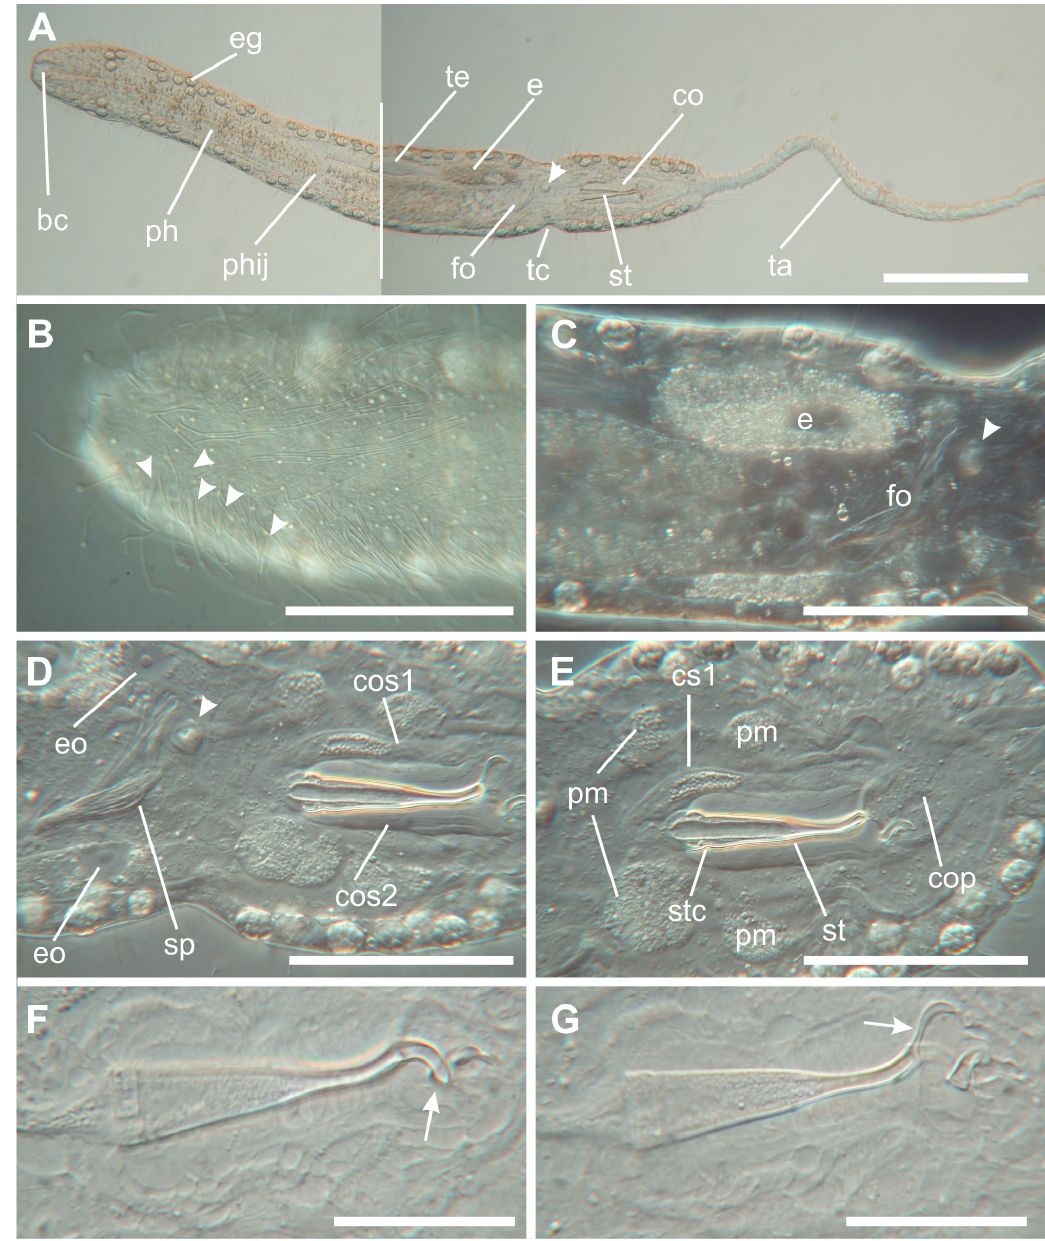
Figure 2. Photomicrographs of Urodasys bi fi dostylis sp. nov. holotype (Nomarski optics). ( A ) Habitus , showing the internal anatomy seen from a dorsal view; the arrowhead indicates the external pore of the frontal organ. ( B ) Details of the anterior end, ventral view, showing the anterior adhesive tubes (arrowheads). ( C ) Details past the mid-trunk region showing the internal organs. ( D , E ) Details of the posterior trunk region, showing the internal organs; the arrowhead indicates the external pores of the frontal organ, inside which two packets of allosperm are seen. ( F , G ) Details of the copulatory stylet seen at di ff erent focal planes, showing the forked posterior end; the arrow indicates the corkscrew-shaped injecting portion while the arrowhead indicated the secondary hooked ex-